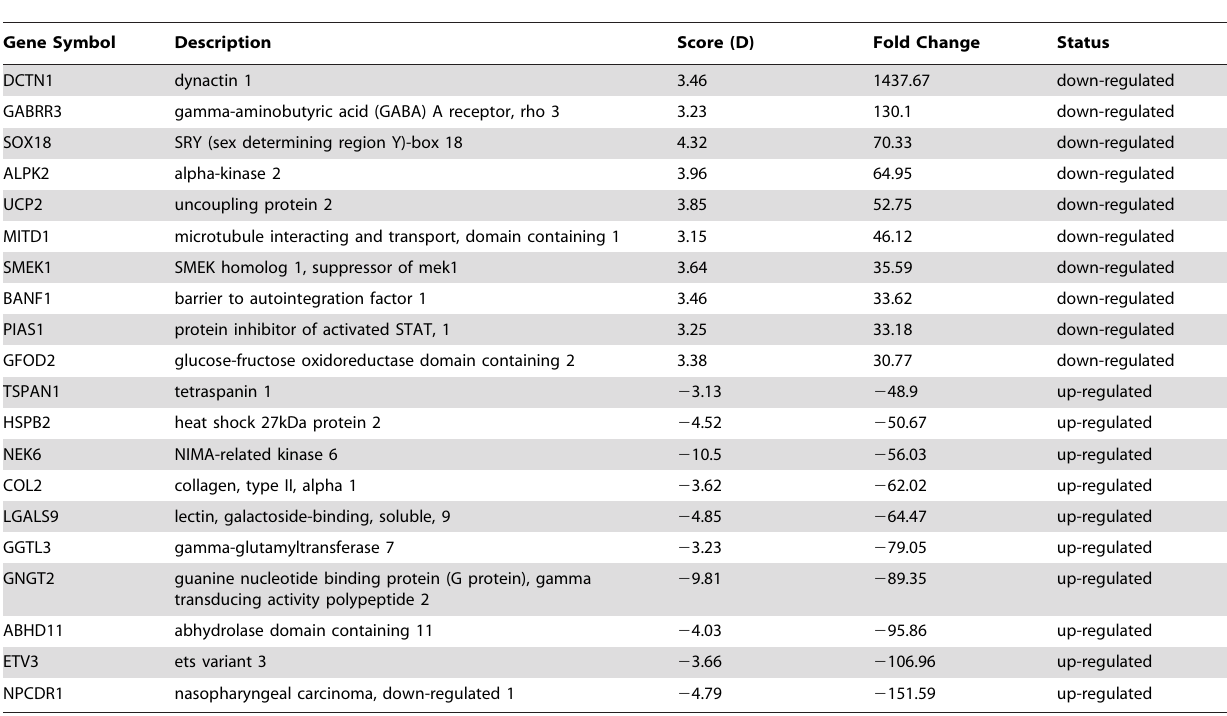
Table 2. Summary of differentially expressed genes between RA vs. NT samples.